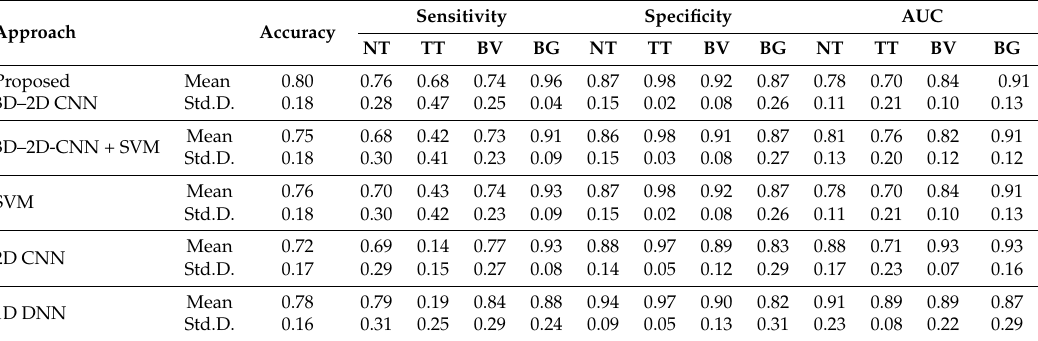
Table 2. Overall results comparison for the approaches evaluated in this study. Accuracy, sensitivity, specificity, and AUC are calculated for each class NT: Normal tissue, TT: Tumor tissue, BV: blood vessels, BG: